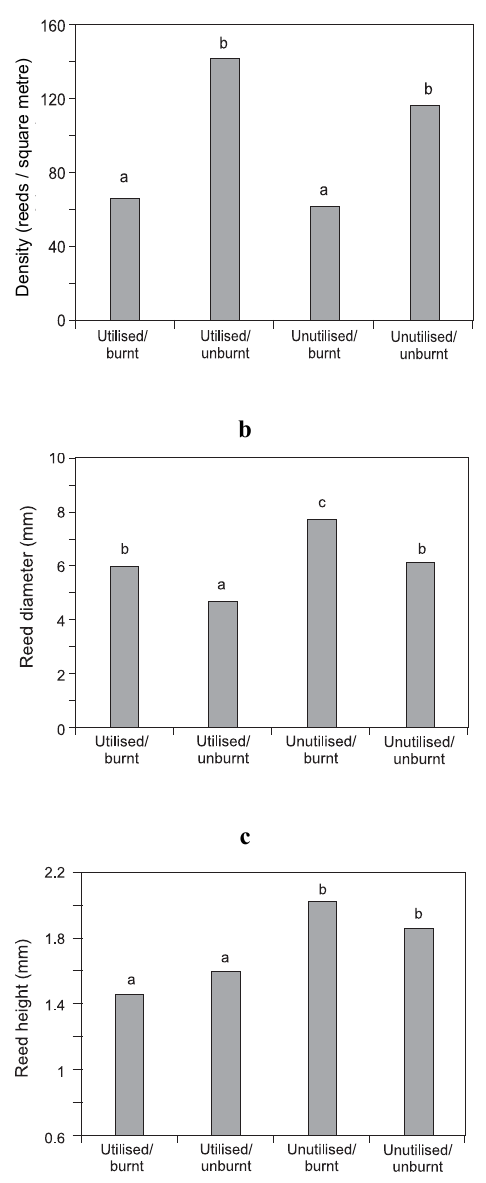
Fig. 4. Phragmites australis reed quality under dif- ferent utilisation and burning regimes in the Muzi Swamp, Tembe Elephant Park as determined by har- vesting trials in 2000: (a) Mean reed density per m²; (b) mean reed diameter; and (c) mean reed height. Bars with different superscripts are significantly dif- ferent ( p < 0.05).